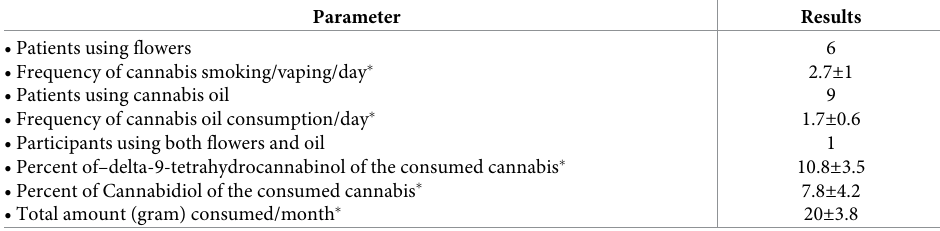
Table 2. Parameters regarding medical cannabis consumption.